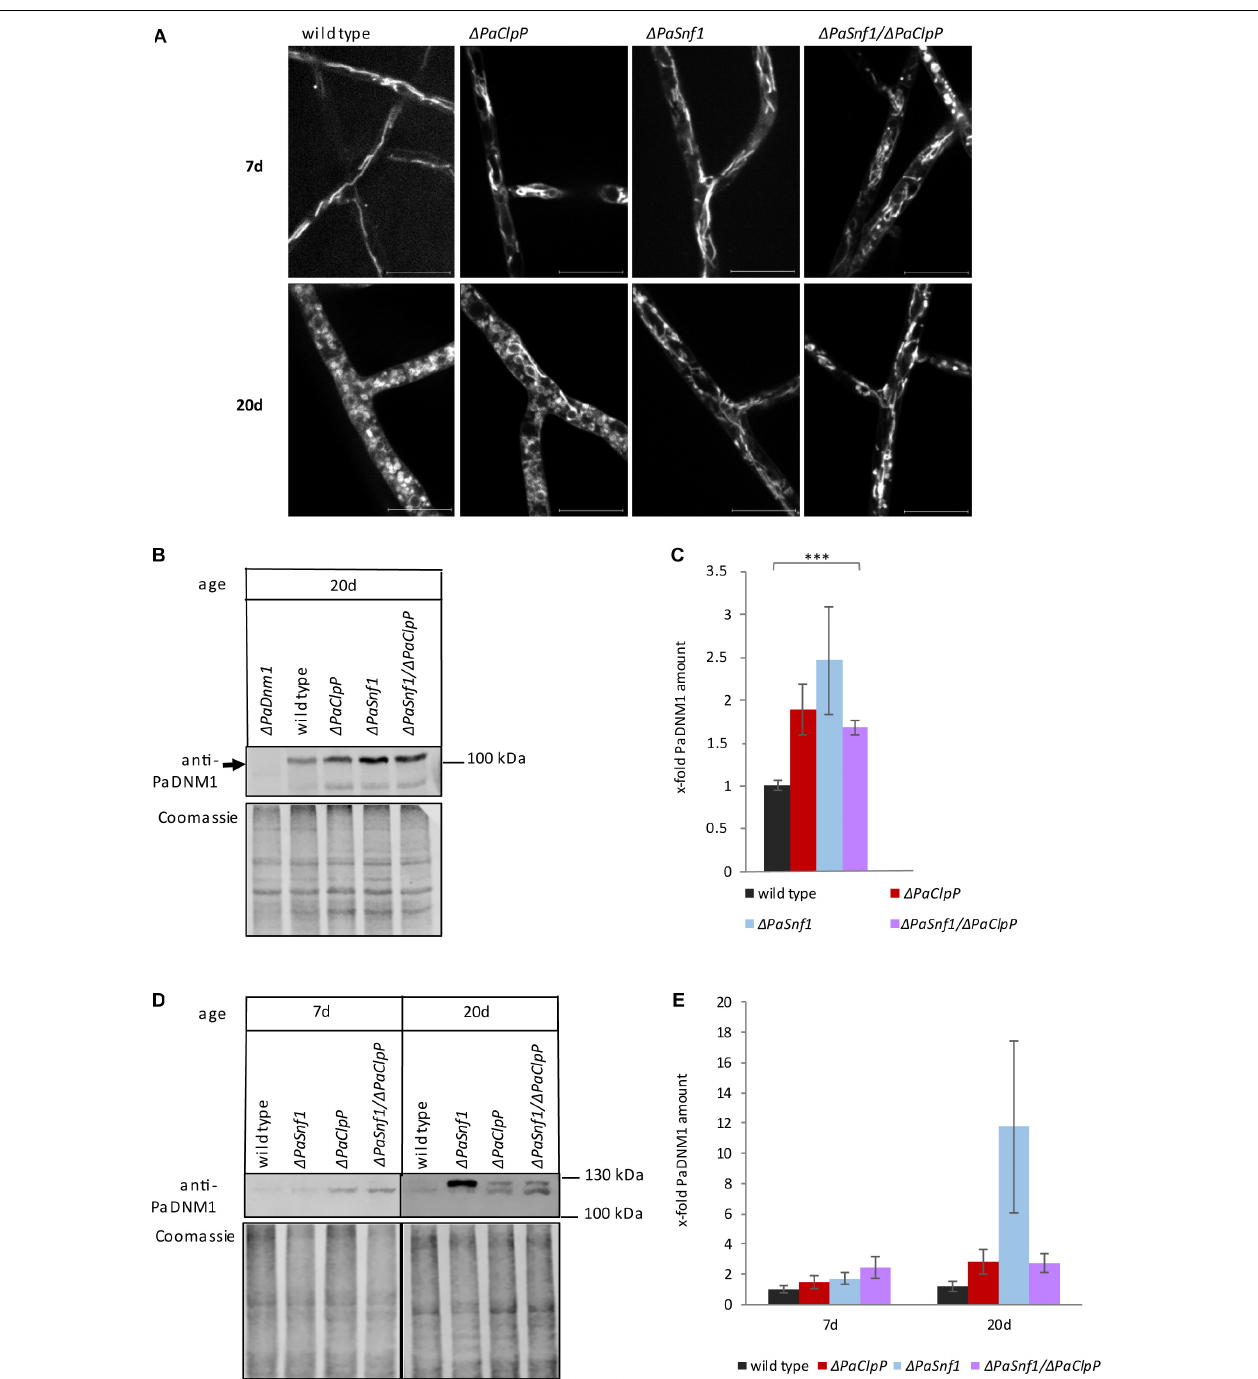
FIGURE 5 | Ablation of PaSNF1 affects mitochondrial morphology. (A) Confocal laser scanning fluorescence microscopy with stained mitochondria of 7- and 20-day-old (cid:49) PaSnf1 , (cid:49) PaClpP , (cid:49) PaSnf1 / (cid:49) PaClpP , and the wild type. After aging on M2 medium at 27 ◦ C (constant light), pieces of mycelium were used to inoculate microscope slides with a central depression filled with M2 media. After a 1-day incubation at 27 ◦ C (constant light), the mycelium was incubated with MitoTracker Red (2 µ M, 15 min, in the dark) to visualize mitochondria. The scale bar refers to 10 µ m. (B) Western blot analysis of 100 µ g total protein extracts of 20-day-old (cid:49) PaSnf1 ( n = 3), (cid:49) PaClpP ( n = 4), (cid:49) PaSnf1 / (cid:49) PaClpP ( n = 4), and wild-type strains ( n = 3) with an anti-PaDNM1 antibody. (C) Quantification of PaDNM1 (B) after normalization to the Coomassie-stained gel. (D) Western blot analysis of 50 µ g mitochondrial protein extracts of 7- and 20-day-old (cid:49) PaSnf1 ( n = 3), (cid:49) PaClpP ( n = 3), (cid:49) PaSnf1 / (cid:49) PaClpP ( n = 3), and wild type strains ( n = 3) with an anti-PaDNM1 antibody. (E) Quantification of PaDNM1 (D) after normalization to the Coomassie-stained gel. (B,D) : 8% SDS polyacrylamide gels were used. After transfer, the gels were stained with Coomassie and served as loading control. The values shown are mean ± SEM ( ∗∗∗ p < 0.001, two-tailed Student’s t -test).